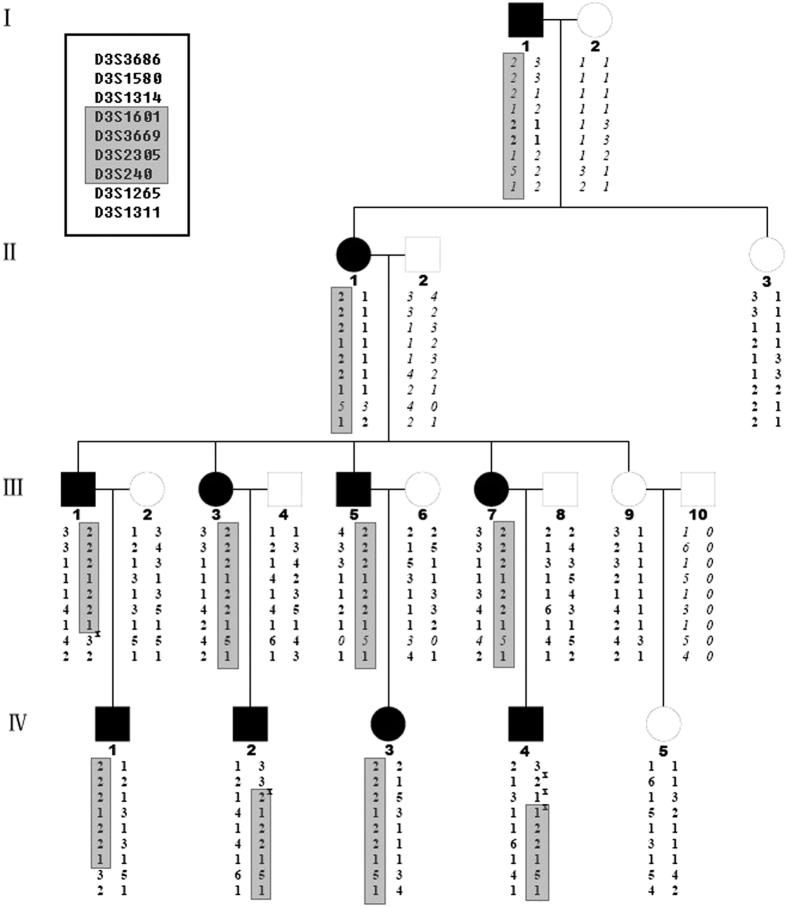
Haplotype Analysis of Family A without PRRT2 gene mutation.The blackened squares and circles denote individuals affected with PKD. Chromosome 3 loci are indicated. Reconstructed haplotypes using these loci are shown under each individual. Grey bars corresponded to the proposed affected haplotype. X indicates a meiotic recombination event.